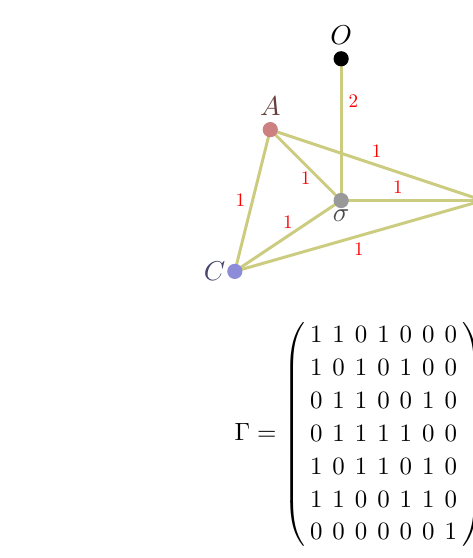
Figure 3. An example of two graph models, with the same underlying topological model but dif- ferent (generic) min-cut structures, corresponding to the same PMI but different min-cut subspaces. The min-cut structures are specified by the Γ matrices, where the rows are labeled by polychromatic indices ( A, B, C, AB, AC, BC, ABC ) and the columns by the edges ( AB, AC, BC, Aσ, Bσ, Cσ, Oσ ) . In both cases the PMI is the full entropy space R 7 (since no mutual information vanishes), but the graph on the left has the 6 -dimensional min-cut subspace S = (1 , 1 , 1 , − 1 , − 1 , − 1 , 1) ⊥ , while for the graph on the right S = R 7 . Note that the 6 -dimensional min-cut subspace of the graph on the left is the hyperplane defined by the vanishing of the tripartite information, corresponding to the saturation of